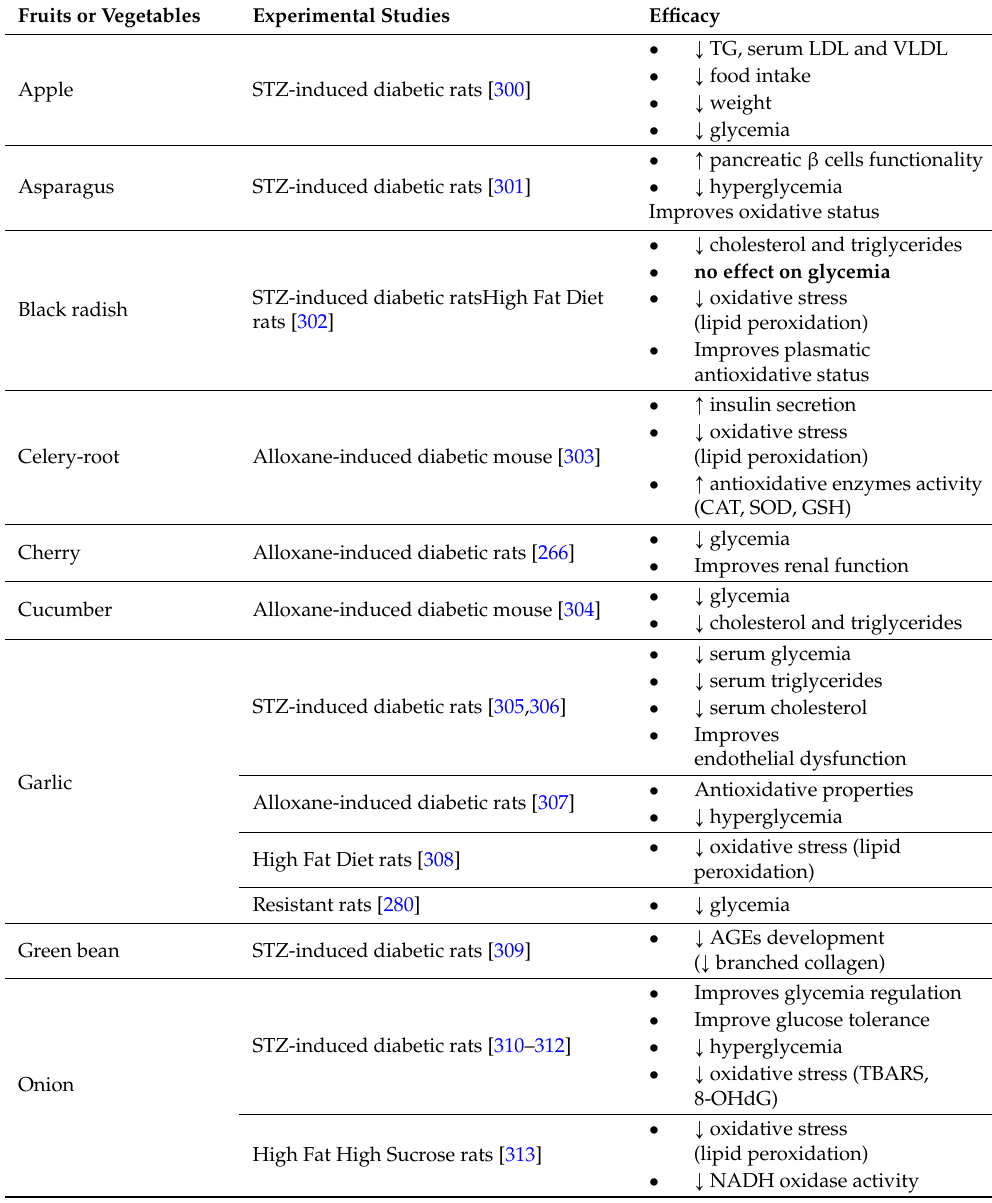
Table 3. Effects of fruits and vegetables on experimental diabetes